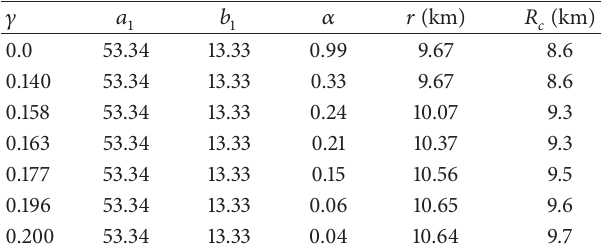
Table 3: Stability of PSR J1614-2230 when 𝑠 1 = 7.5 and 𝛼 , 𝛾 are variable.